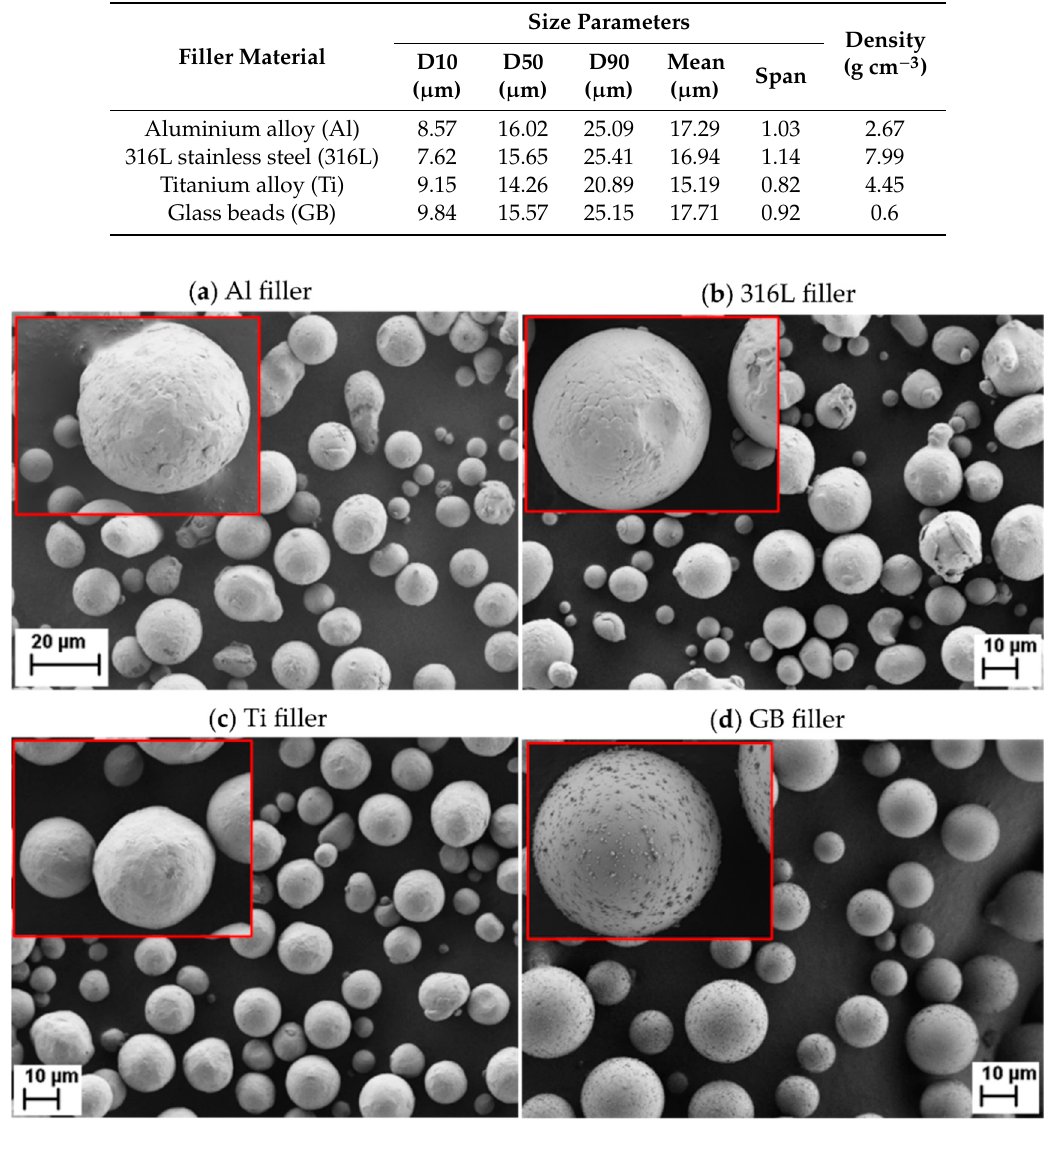
Figure 2. Scanning electron microscopy (SEM) micrographs of spherical filler materials: ( a ) AlSi10Mg aluminium alloy; ( b ) 316L stainless steel particles; ( c ) Ti6Al4V titanium alloy; ( d ) iM16K glass beads. The scale does not apply for the zoomed images in upper left corners.